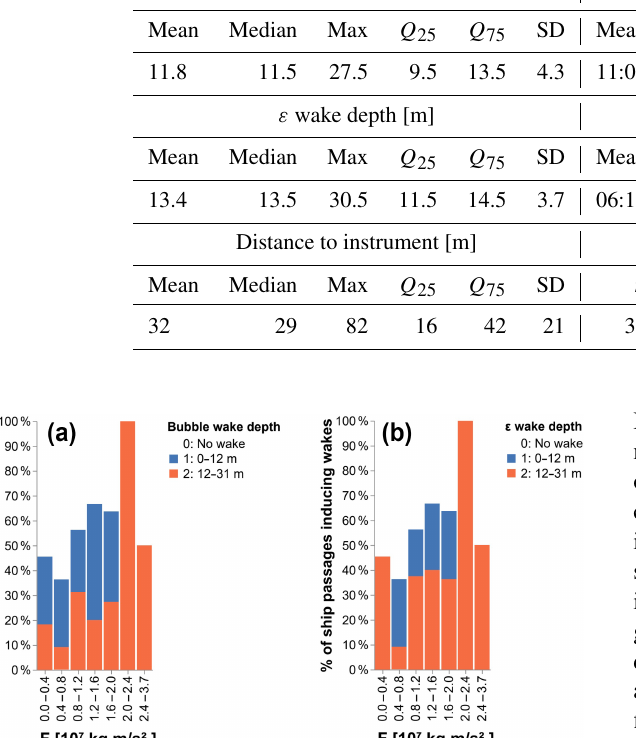
Table 2. Mean, median, and maximum value, first quartile ( Q 25 ), third quartile ( Q 75 ), and standard deviation (SD) for wake depth and longevity for the observed wakes induced by ships passing zero to three ship widths from the ADCP instrument. Bubble wake depth [m]